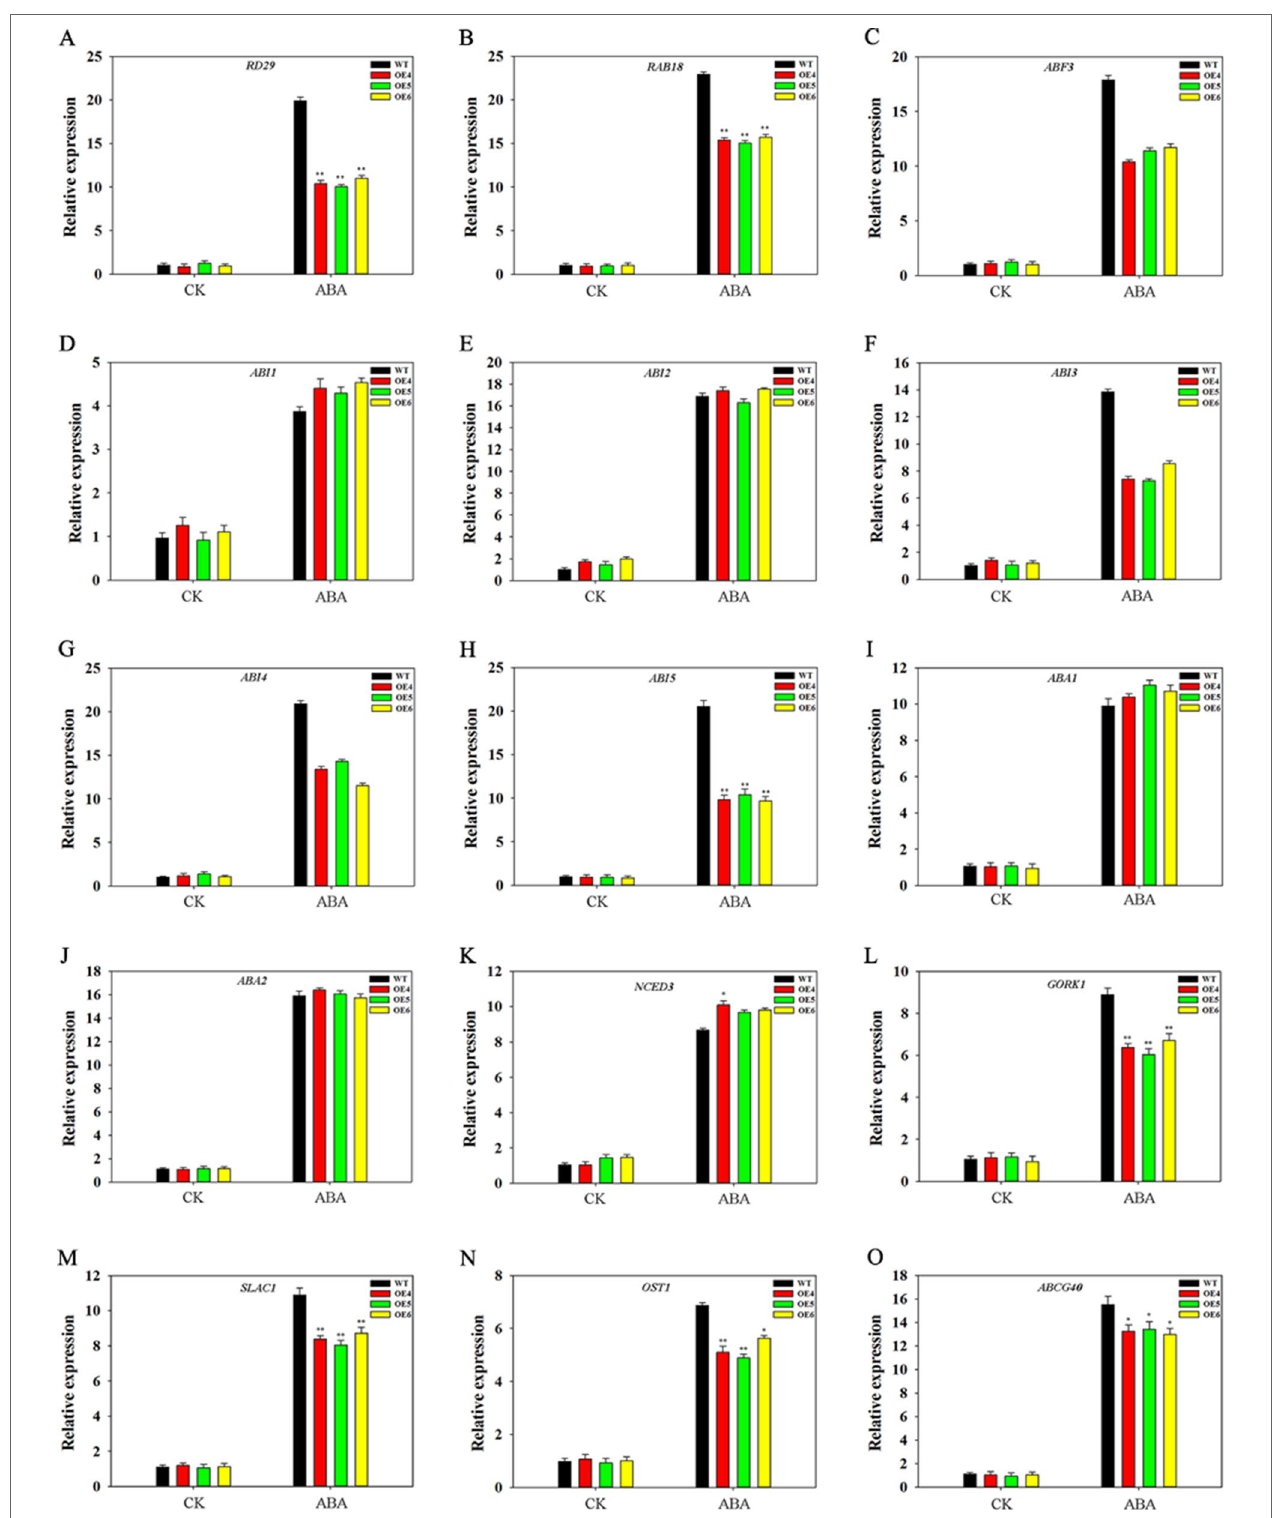
FIGURE 9 | Expression patterns of ABA-associated genes in WT and TaFBA1-overexpressing (OE4, OE5, OE6) Arabidopsis plants under ABA treatment. (A – H) Expression levels of ABA-response genes, including RD29 , RAB18 , ABF3 , ABI1 , ABI2 , ABI3 , ABI4 , ABI5 . (I – K) Expression levels of ABA-synthesize associated related genes, including ABA1 , ABA2 and NCED3 . (L – O) Expression of genes involved in stomatal movement, including SLAC1 , OST1 , GORK1 , and ABCG40 . Data represent mean ± SE of three biological replicates. * P < 0.05; ** P <